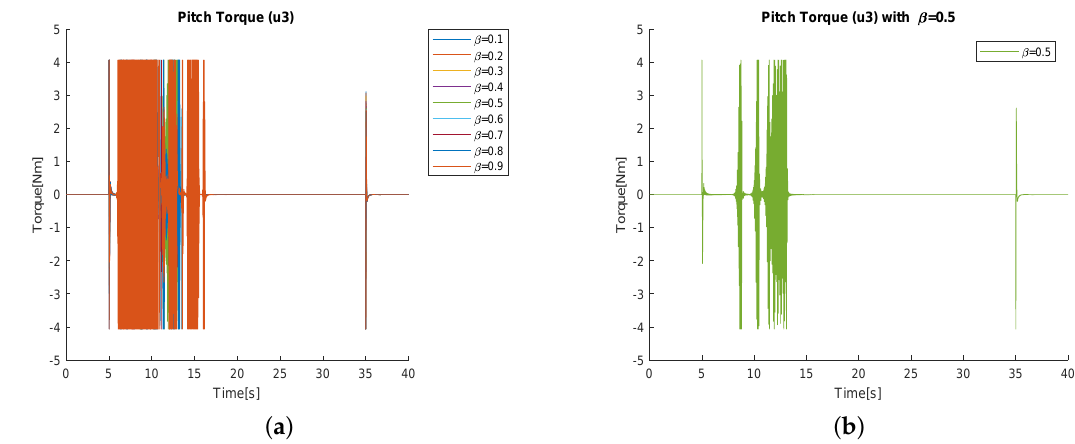
Figure 14. ( a ) Pitch Torque with distinct β ’s; ( b ) Pitch Torque with β =